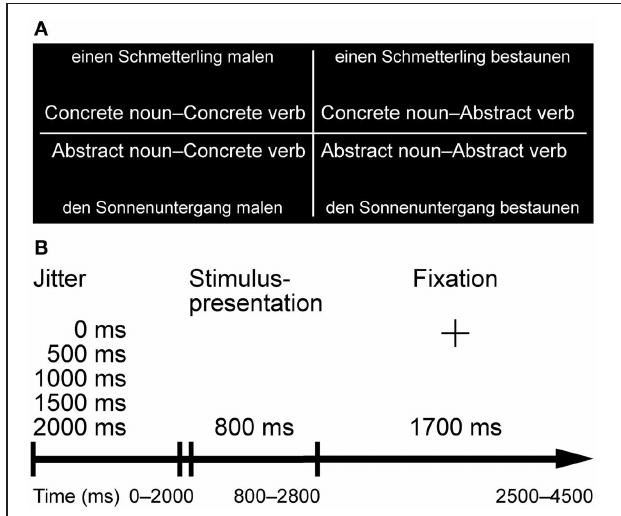
FIGURE 1 | Experimental design with an exemplary stimuli combination (A) and trial procedure (B). Each noun referring to a graspable object, preceded by a determinative or non-determinative article, was combined with an adequate motor verb as well as an adequate non-motor verb, and an adequate noun referring to a non-graspable entity was combined with the same verbs previously used, e.g., “einen Schmetterling malen” (to draw a butterfly), CC—“einen Schmetterling bestaunen” (to marvel at a butterfly), CA—“den Sonnenuntergang malen” (to draw the sunset), AC—“den Sonnenuntergang bestaunen” (to marvel at the sunset), AA. Note that according to the German word order the noun is presented first followed by the verb. Due to the variable onset delay (jitter) the trial duration was 2500ms at minimum to 4500ms at